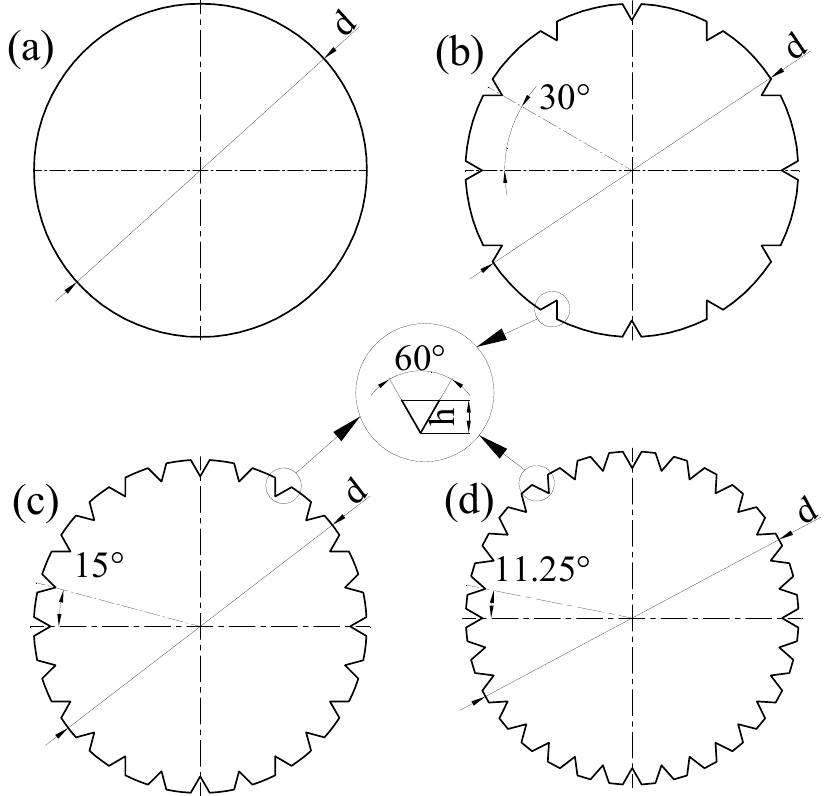
Figure 1. Experimental models: ( a ) smooth cylinder, ( b ) 12-groove cylinder, ( c ) 24-groove cylinder, ( d ) 32-groove cylinder.